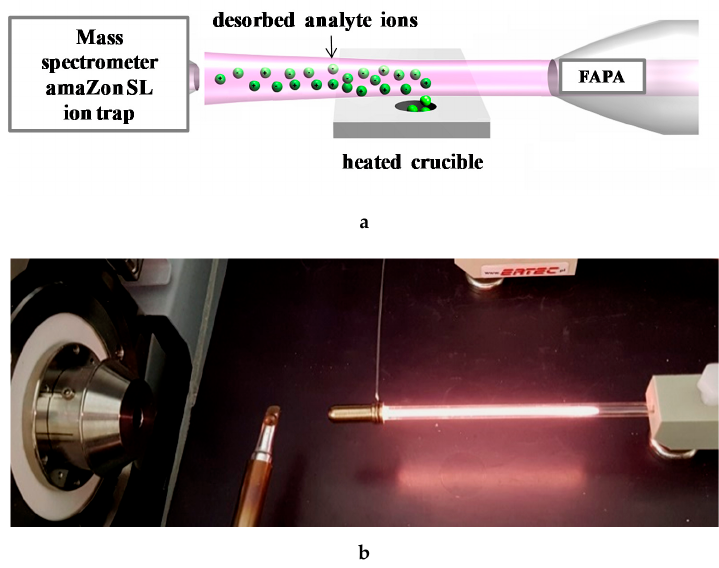
Figure 9. ( a ) Scheme the measuring system: FAPA ionization source, heated crucible, and amaZon SL mass spectrometer. ( b ) The measuring system: FAPA ionization source, heated crucible, and mass spectrometer inlet.